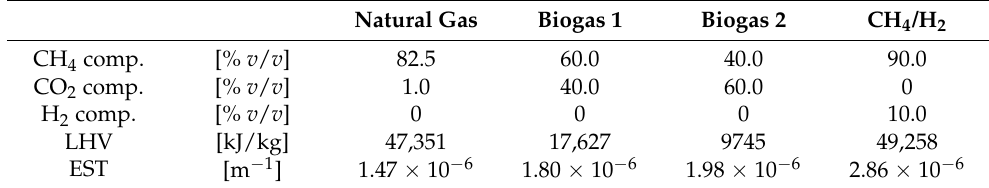
Table 1. CFD results of fluids passing in high pressure pipe (partial data from reference [31]). Natural